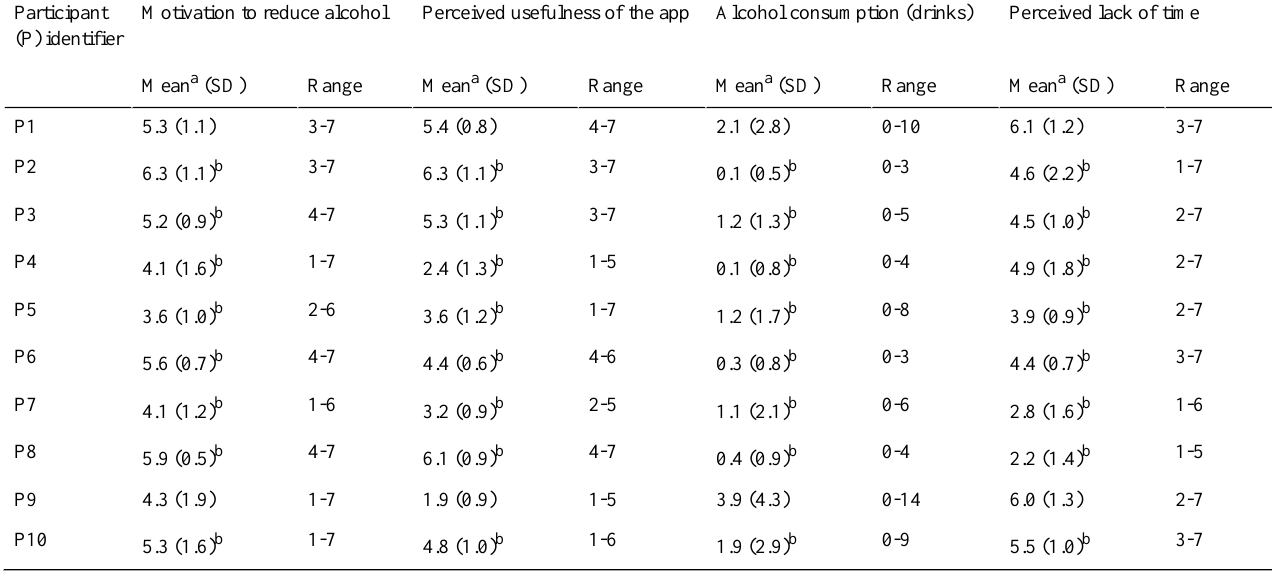
Table 4. Descriptive statistics for the predictor